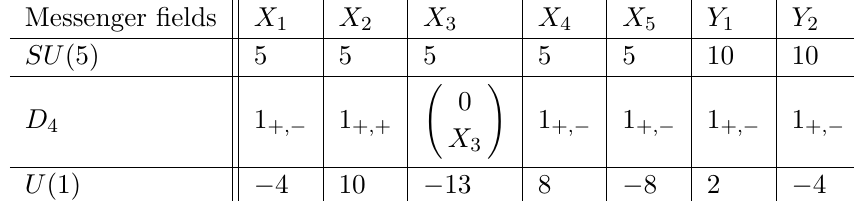
live in 10 -dimensional i